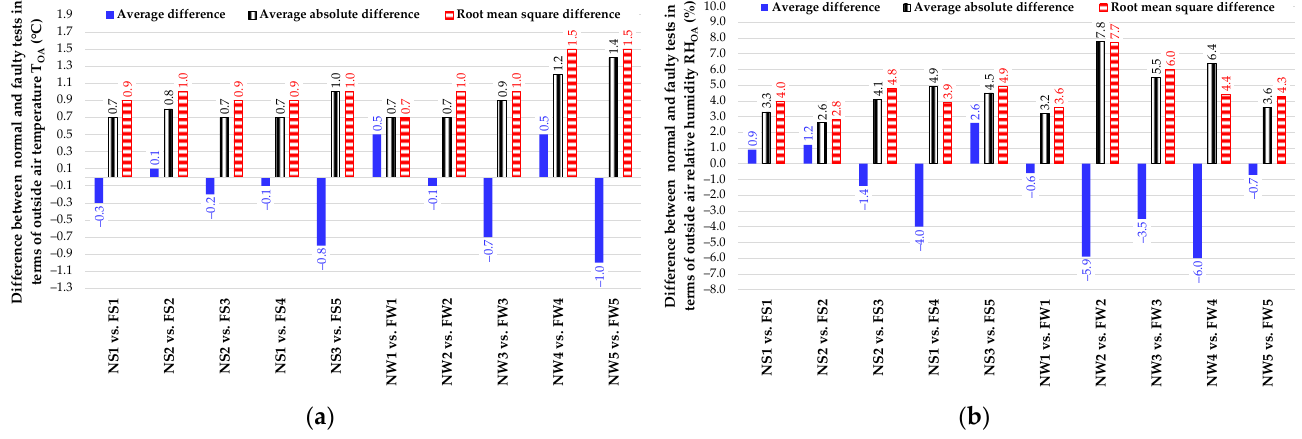
Figure 3. Comparison of fault-free and faulty tests in terms of ( a ) outside air temperature T OA and ( b ) outside air relative humidity RH OA